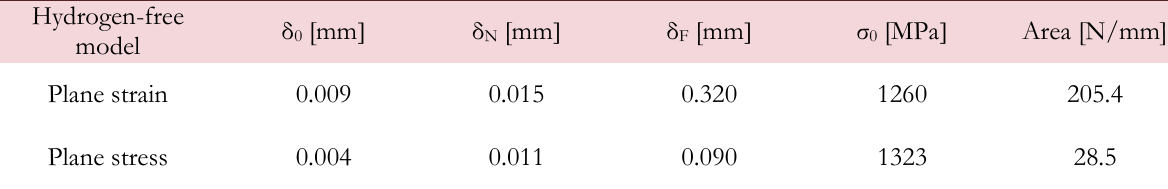
Table 2: Characteristic values for TSL parameters for the hydrogen-free model, for plane strain and plane stress models. Displacement and stress notation is referred to Fig. 1; the area is below the TSL